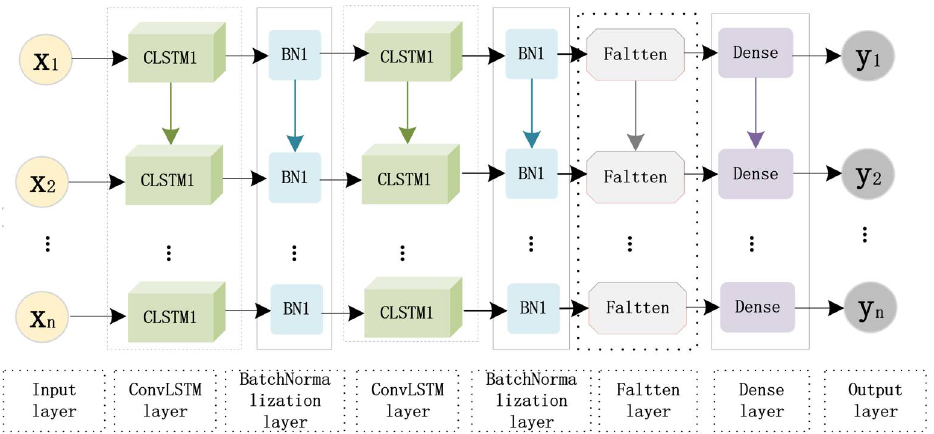
Figure 7. Diagram of the internal structure for the model.